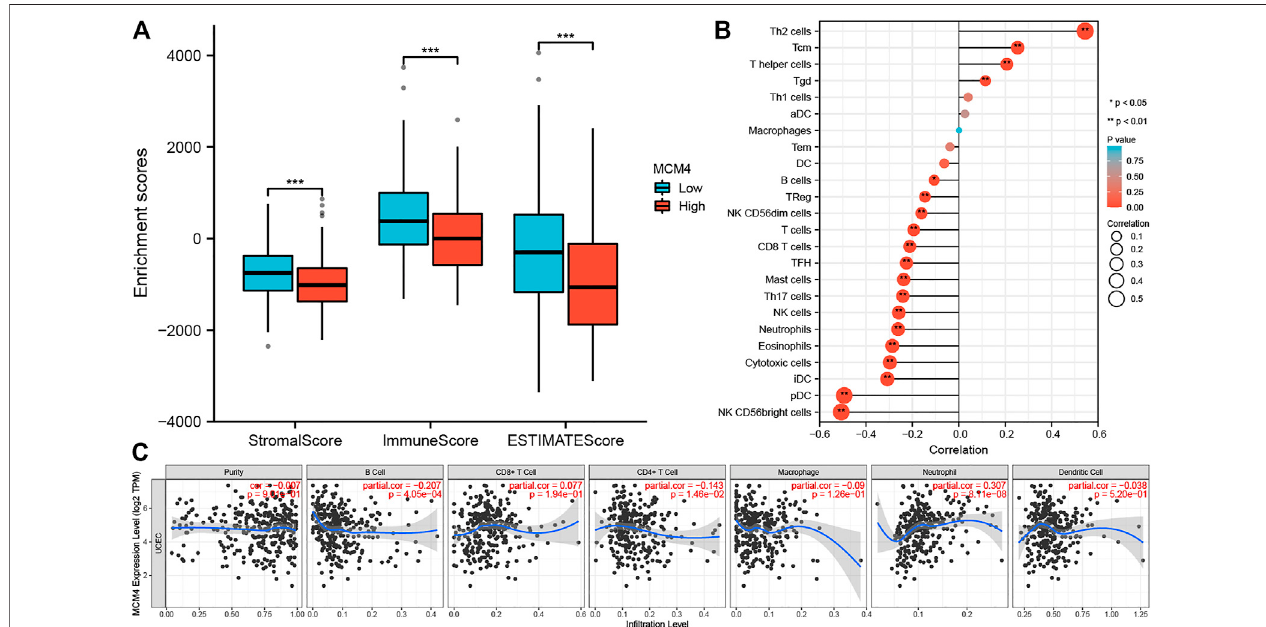
FIGURE 4 | The relationship between the MCM4 gene and the tumor microenvironment and immune cell in fi ltration. (A) Patients with the high MCH4 expression hadthelowerstromalscore,immunescore,andestimatescore. (B) Thelollipopplotshowedasigni fi cantpositivecorrelationbetweenMCM4andfourimmunecelltypes and a signi fi cant negative correlation between MCM4 and 15 immune cell subpopulations. (C) MCM4 signi fi cantly correlated with B cell, CD4 + T cell, and Neutrophil in fi ltration in UCEC based on the Timer2.0 database. *: p -value < 0.05; **: p -value < 0.01; ***: p -value < 0.001. TIMER, tumor immune estimation resource.